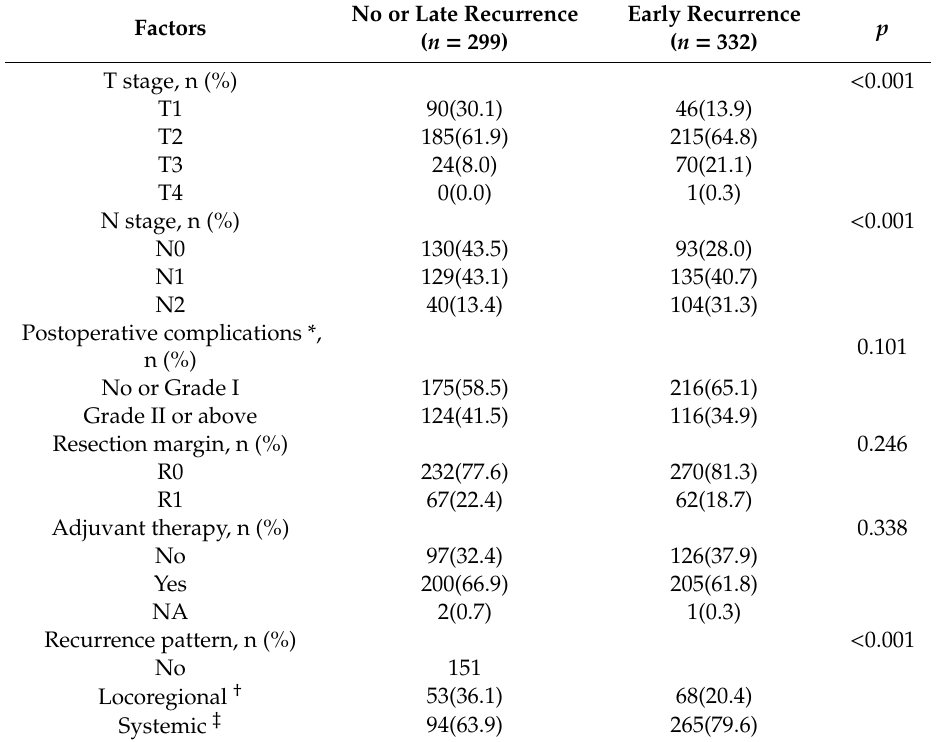
Table 3. Comparison of postoperative factors between recurrence groups in the training set ( n =